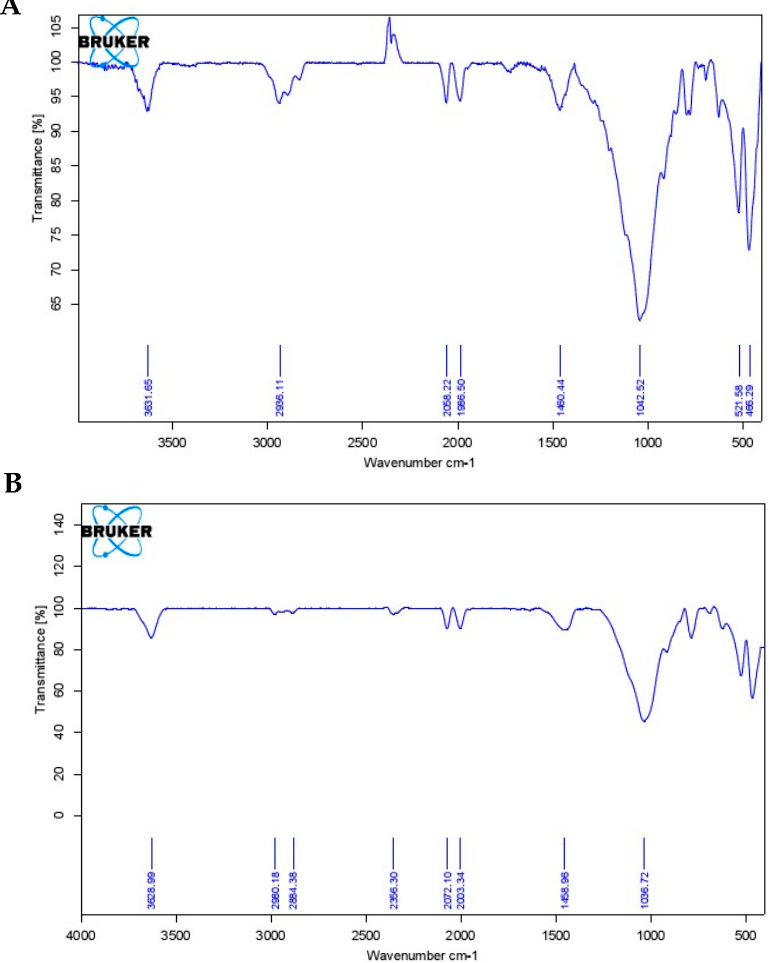
Figure 3. The Infrared (IR) spectrum of MMT-RuCl x (CO) y complexes after carbonylation of montmorillonite with CORM-2 [Ru(CO) 3 Cl 2 ] 2 of Ru@MMT-1 ( A ) and Ru@MMT-2 ( B ).